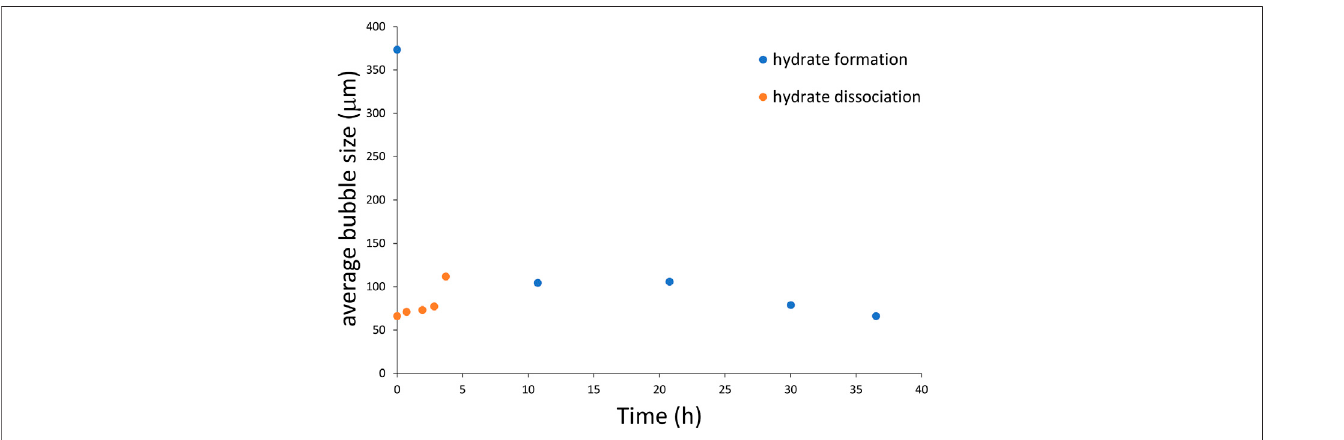
FIGURE 9 | Average bubble size (d50) evolution with hydrate formation and dissociation. The large average bubble size before formation is observed, which is irrecoverable after the dissociation stage.